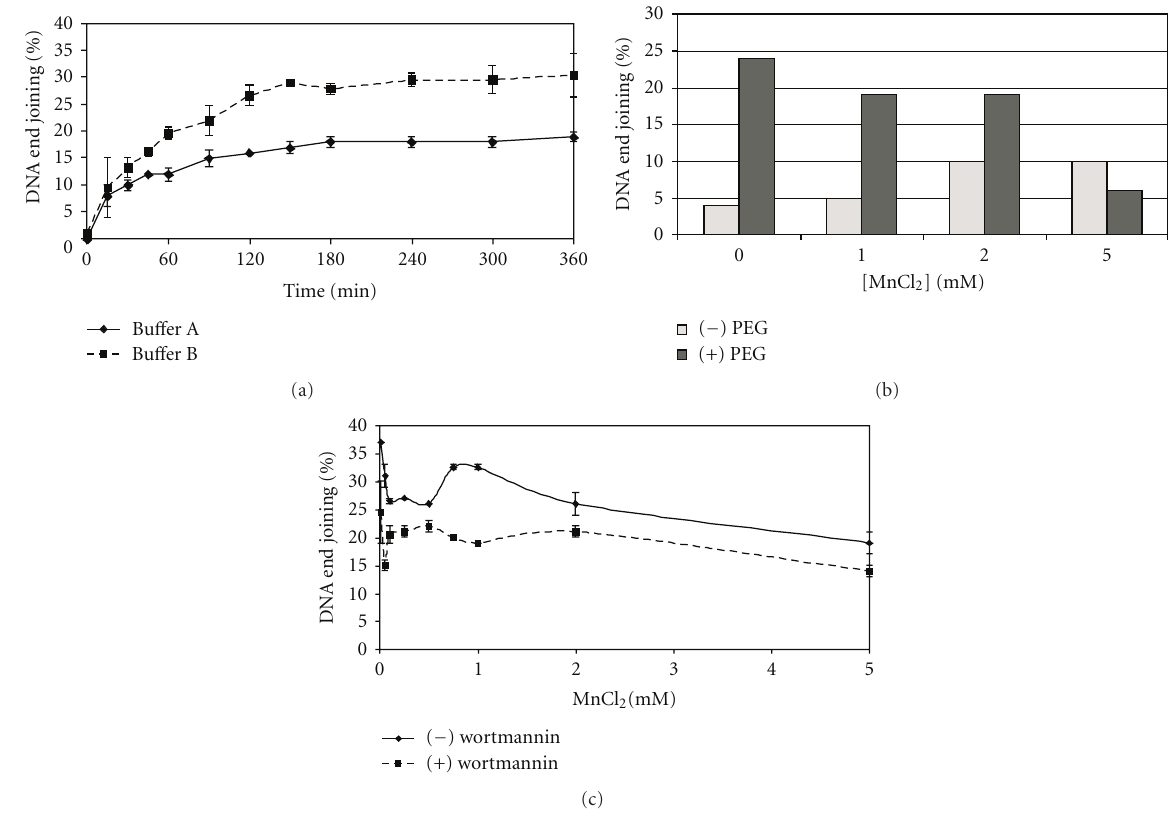
Figure 4: E ff ects of reaction conditions on DNA end-joining activity. (a) Reaction bu ff er composition e ff ects on HeLa WCE end-joining activity time course reactions in the presence of 5% PEG. Reactions were run at 30 ◦ C for the times indicated in either of the two standard reaction bu ff ers as described in the text. The mean values of triplicate reactions were plotted and the error bars indicate standard deviation. (b) E ff ects of MnCl 2 on HeLa WCE DNA end-joining activity. Reactions were run with the addition of 0–5 mM MnCl 2 to standard DNA end-joining reactions containing 5 mM MgCl 2 for 2 hrs at 30 ◦ C in the presence or absence of 5% PEG as indicated. (c) The DNA end-joining reactions employing MnCl 2 (0–5 mM) in the presence of PEG were repeated with and without 10 μ M wortmannin (6hrs at 30 ◦ C). Reactions were run in triplicate and the error bars indicate standard